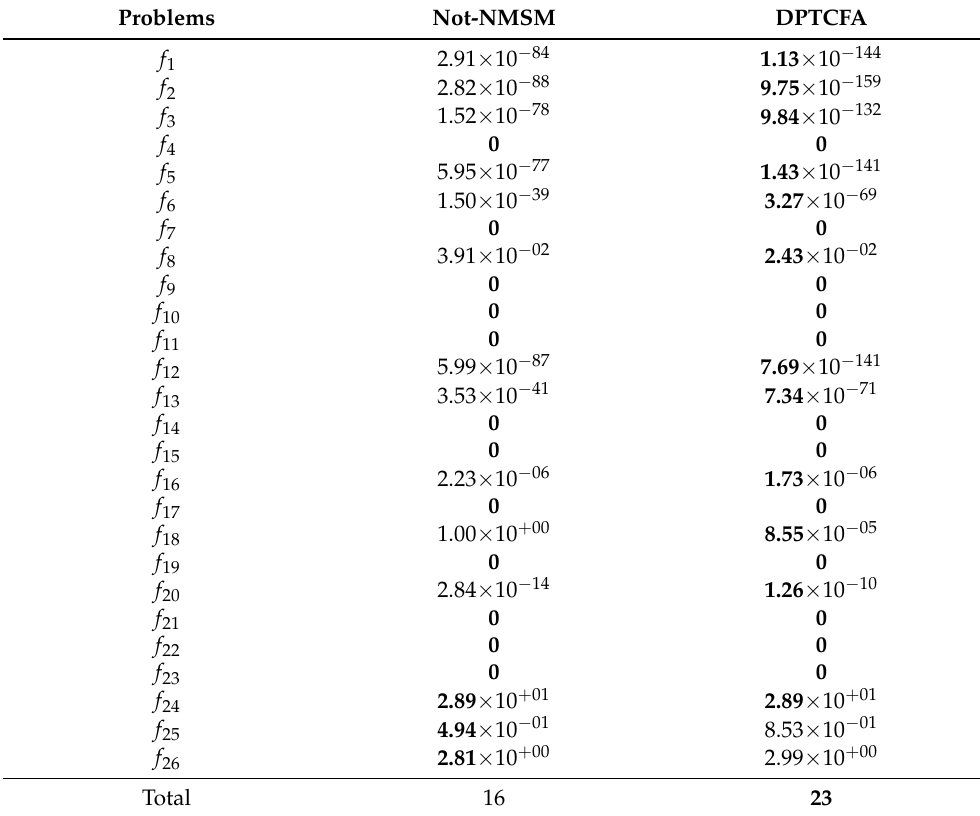
Table 10. Comparison of results obtained by DPTCFA and non-NMSM ( D = 30).